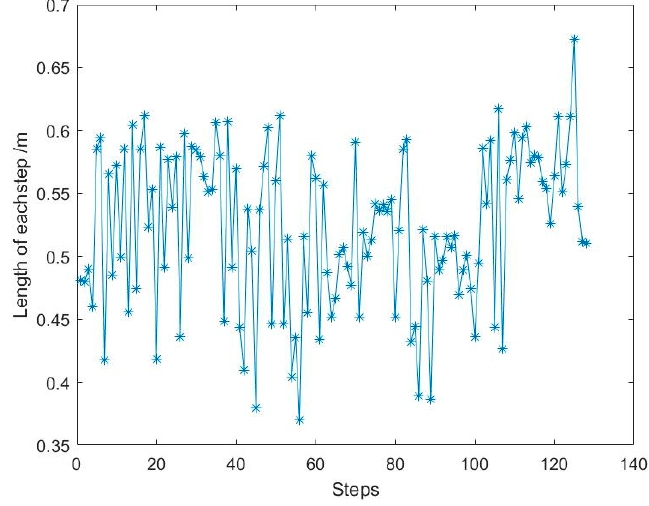
Figure 12. Calculation results of pedestrian motion step size.